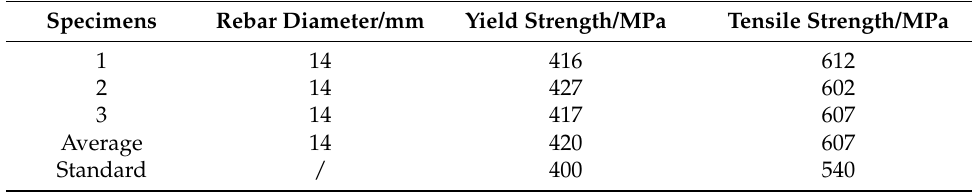
Table 7. HRB400 rebar material